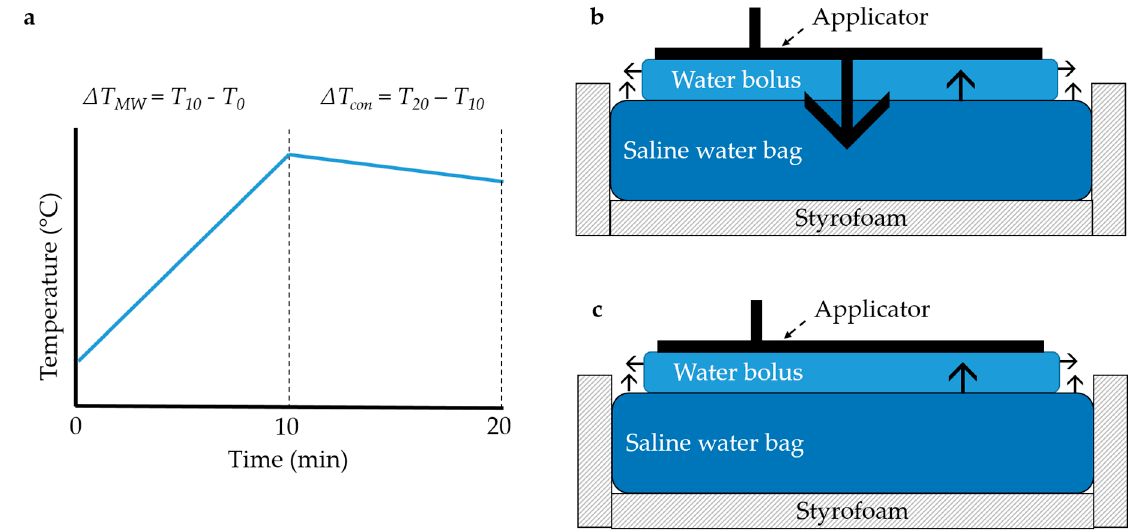
Figure 3. The experimental set-up to determine the applicator efficiency. ( a ) Power was applied for